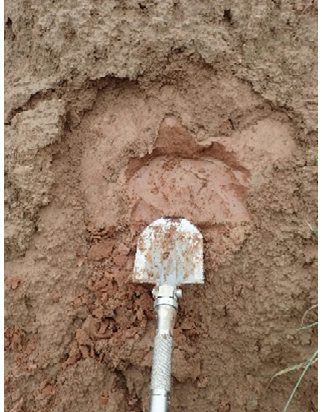
Figure 5. Silty clay in the landslide site.